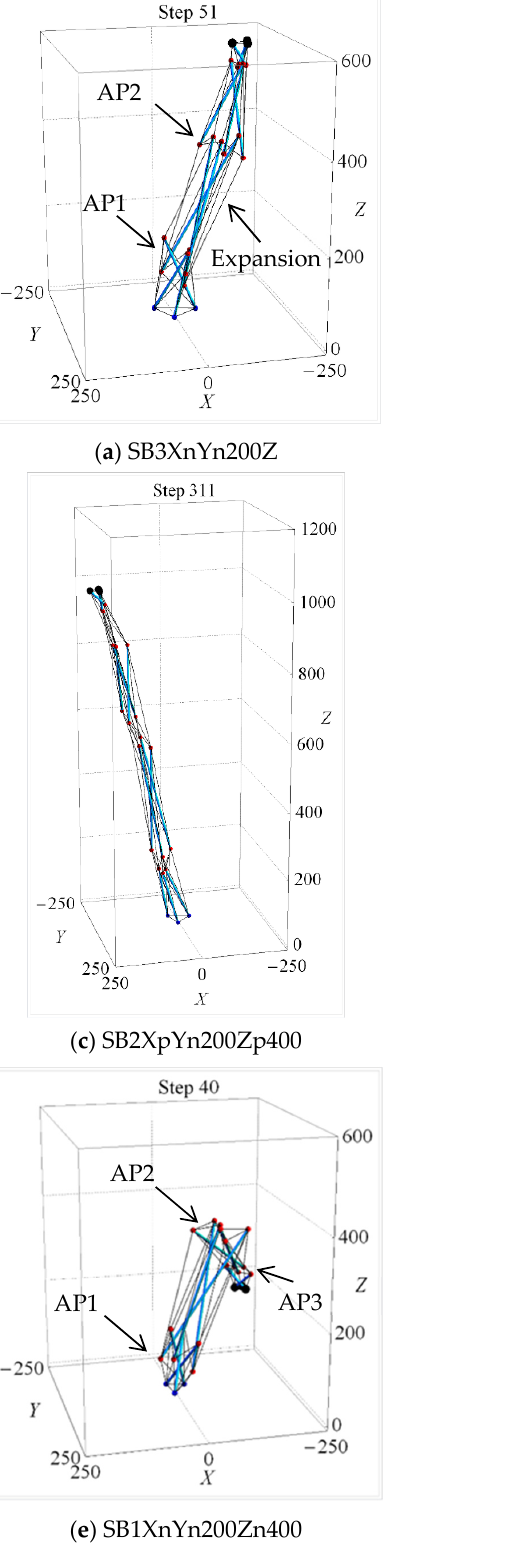
Figure 18. Deformed configuration ( a – f ) at the final step for cases with the tri ‐ directional mode.